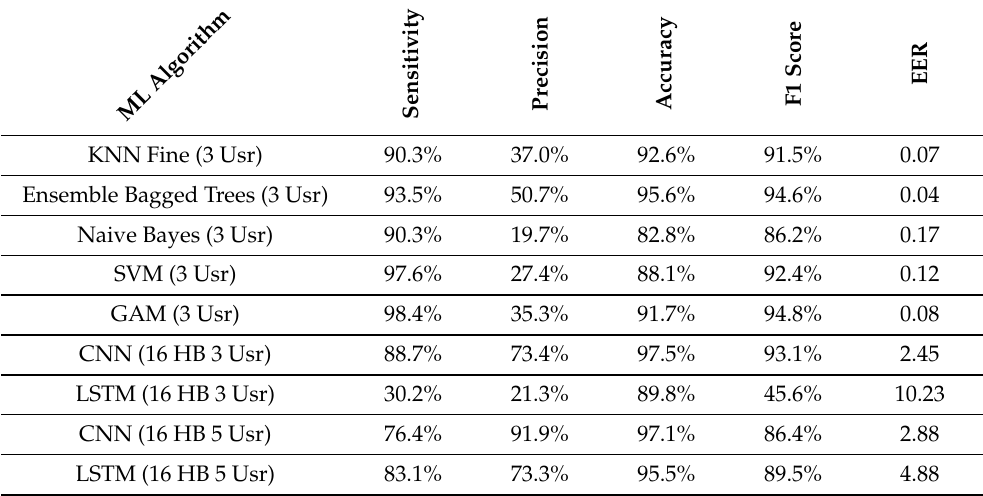
Table 9. ECG-PPG Fusion Result Details—Multiuser